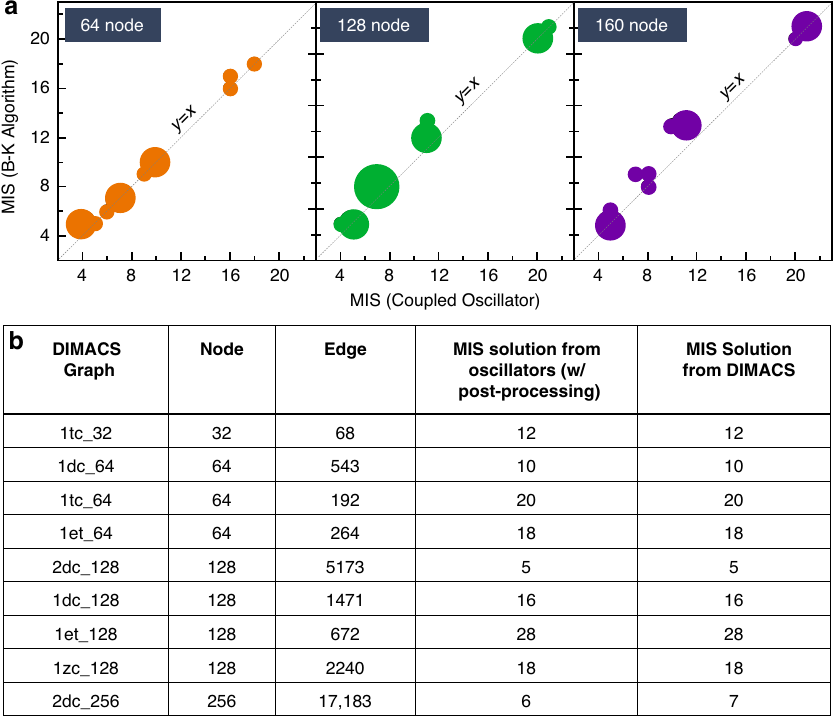
Fig. 4 Scalability of coupled oscillator approach. a Bubble plots comparing the MIS solution obtained from the coupled oscillators (post expansion step) relative to the optimal solution (obtained from the B – K algorithm). b Graph instances from the DIMACS implementation challenge solved using coupled oscillators; the oscillators compute the optimal MIS solution in all except one